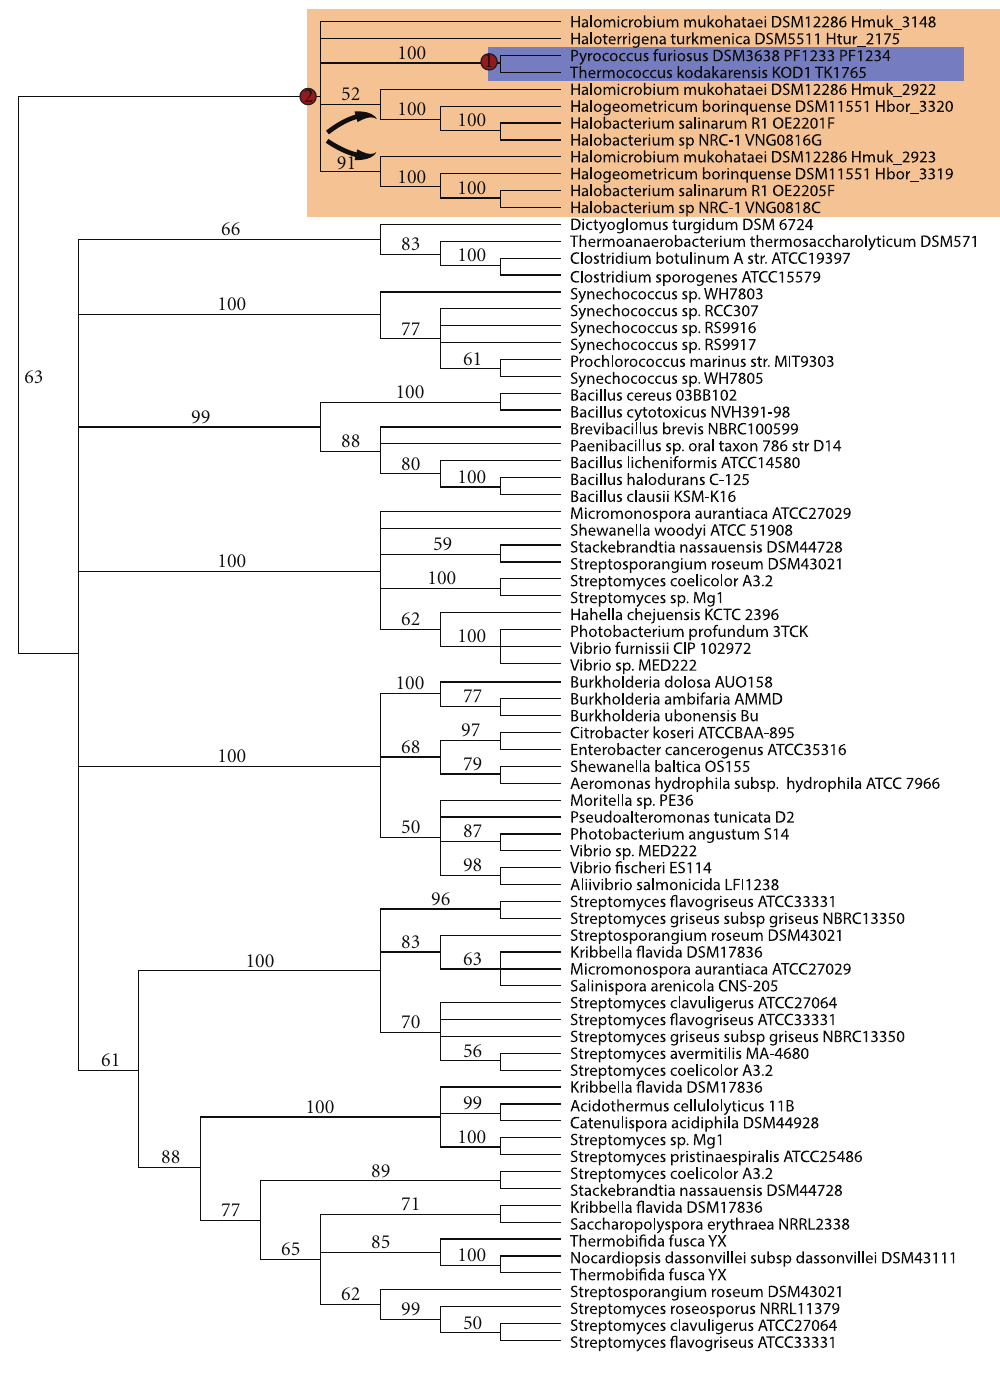
Figure 13: Chitinase. Phylogenetic tree for glycosyl hydrolase family 18